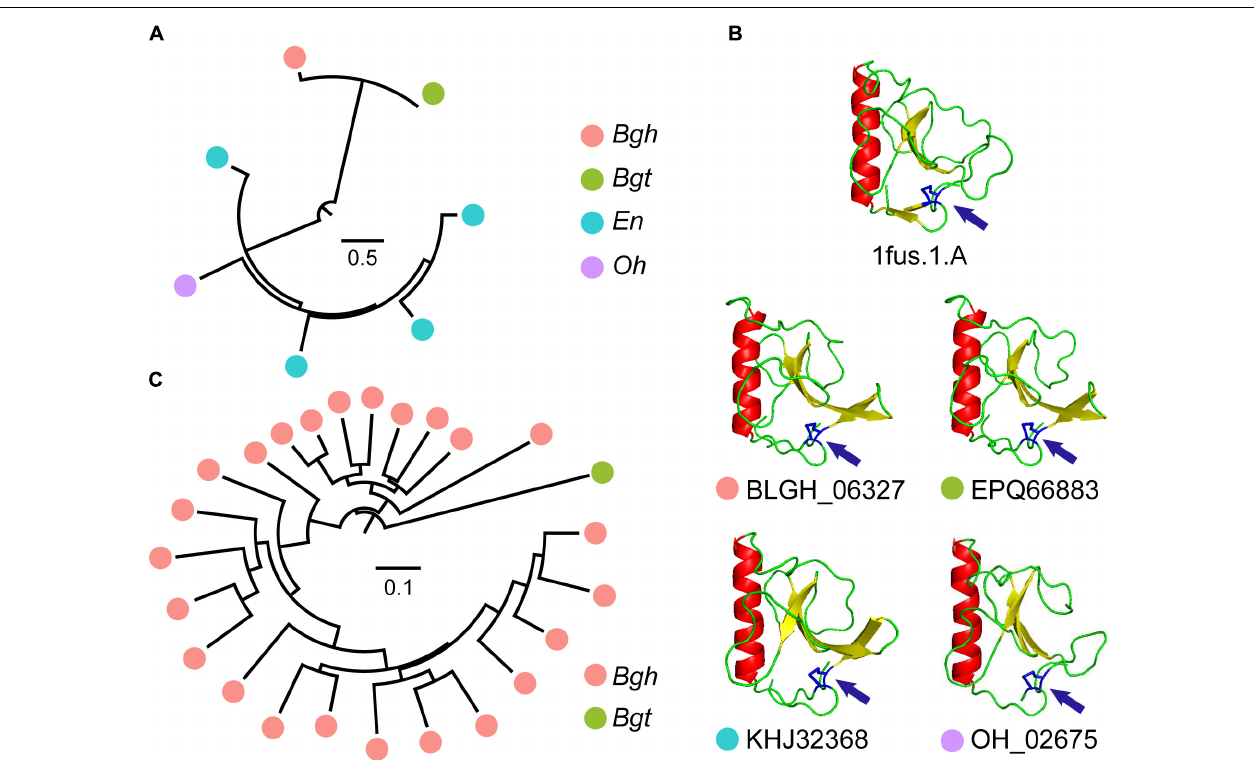
FIGURE 5 | Ribonuclease-CSEP duplicates from a common ancestor and their conserved structure. (A) Phylogenetic analysis of OG15 CSEPs reveal gene expansion in dicot powdery mildews. The color of the circles indicates different powdery mildew species. (B) Similar ribonuclease 3-dimensional structures for OG15 CSEPs. The 1fus.1.A model is a ribonuclease template. Arrows indicate predicted disulfide bonds between N- and C-terminal cysteines. (C) Phylogenetic analysis of OG1 CSEPs reveals duplication in monocot powdery